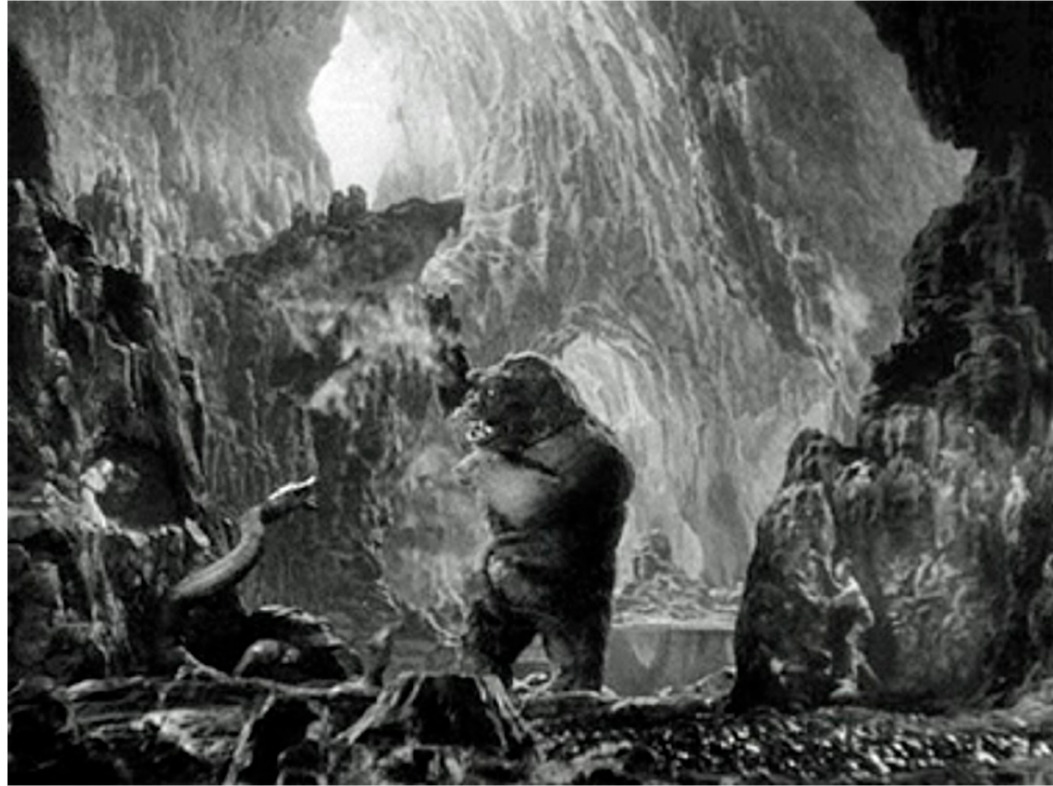
Figure 8. The circular door of King Kong’s lair (1933). http://www.californiaherps.com/films/snakefilms/KingKong1933.html (accessed on 1 January 2021).